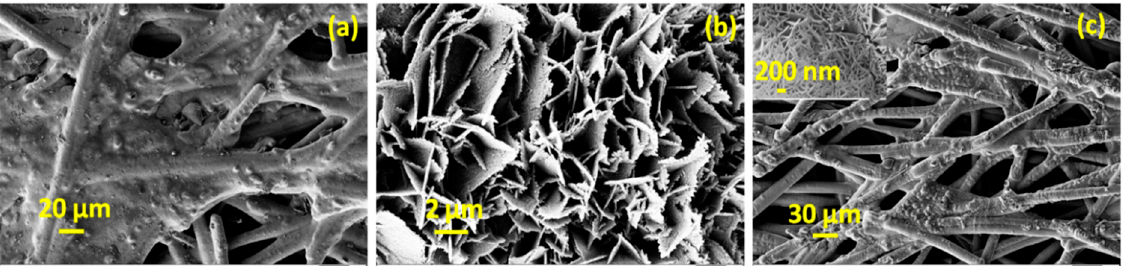
Figure 3. The FE-SEM images of ( a ) Ni-coated TC, ( b ) Fe-coated TC, and ( c ) NiFe-LDH formation on TC (insert shows high magnification image).